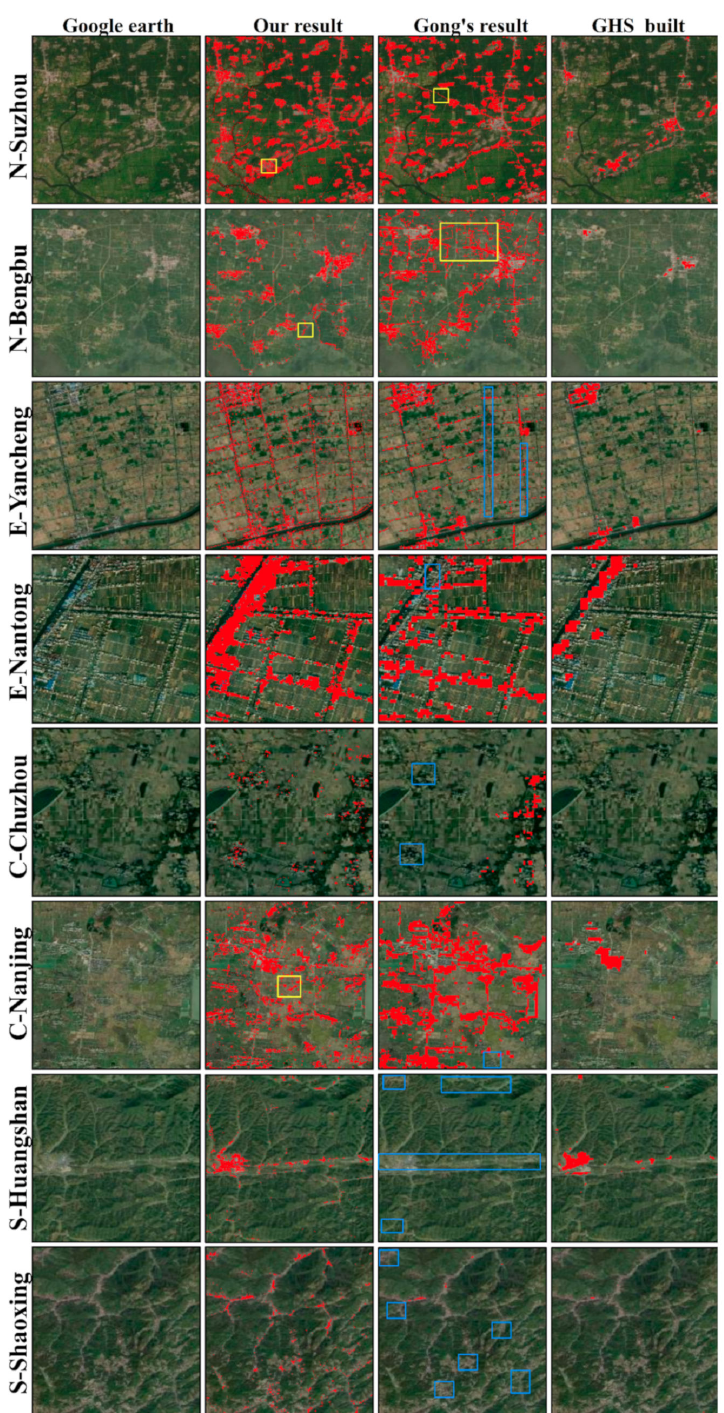
Figure 10. Comparisons between our rural settlement product (the 2nd column), human settlements in China developed by Gong et al. (2019) [16] (the 3rd column), and the GHSL products developed by Melchiorri M et al. (2018) [59] (the 4th column) for eight cities. N, E, C, and S represent the Northern Plain, East Coast, Central Hills, and Southern Mountain, respectively. The yellow and blue boxes indicate the errors of commission and omission,